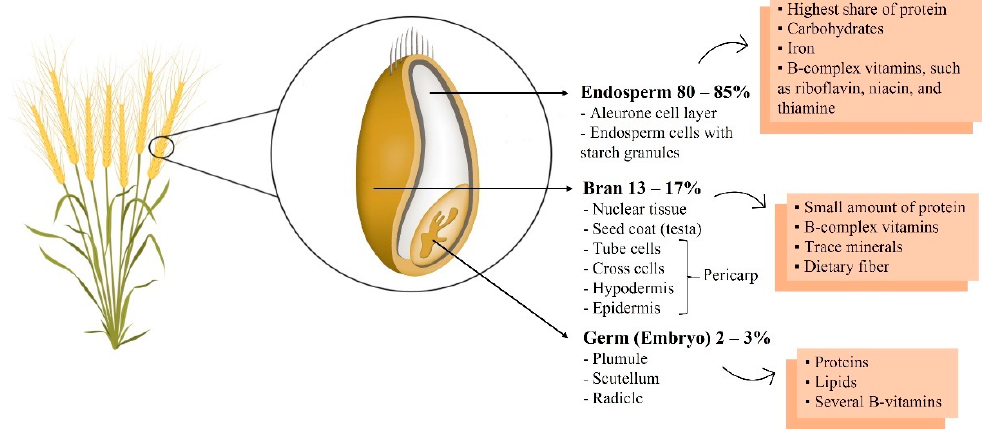
Figure 1. Wheat grain